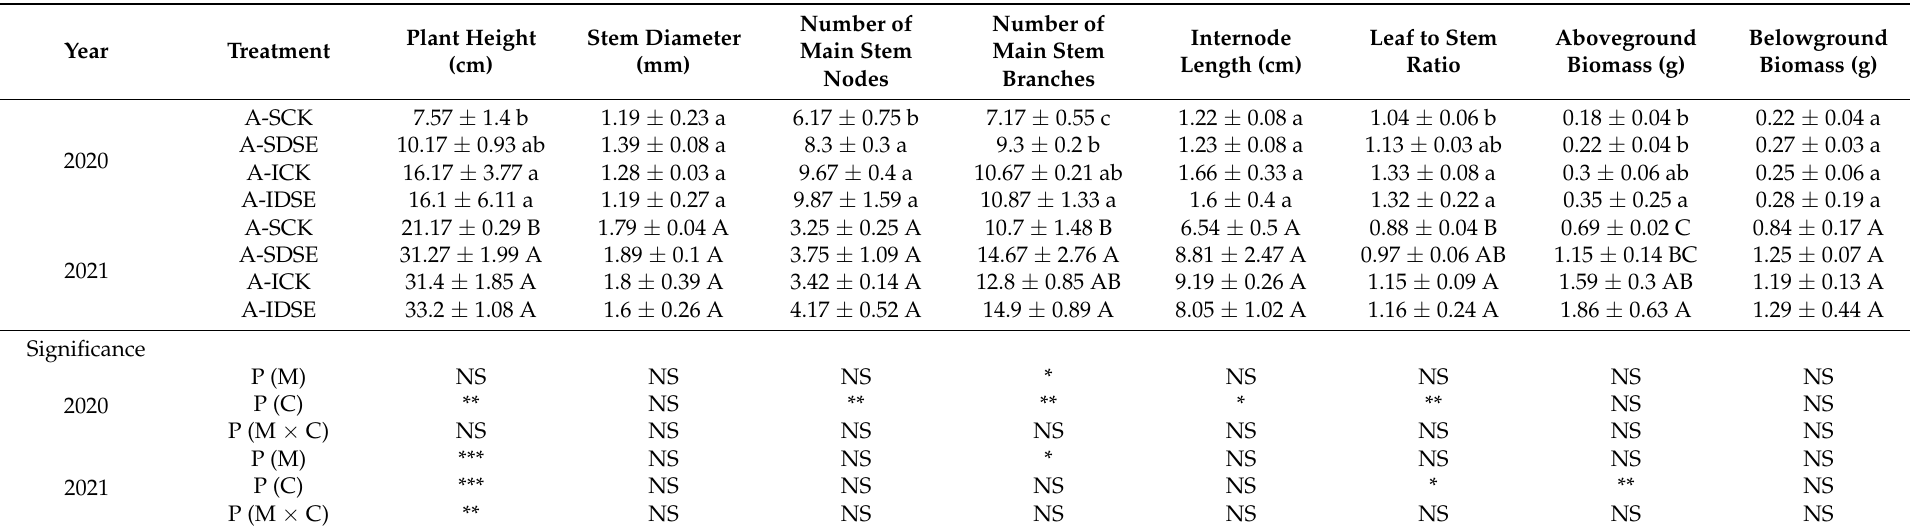
Table 2. Effects of the different treatments on the yield components of